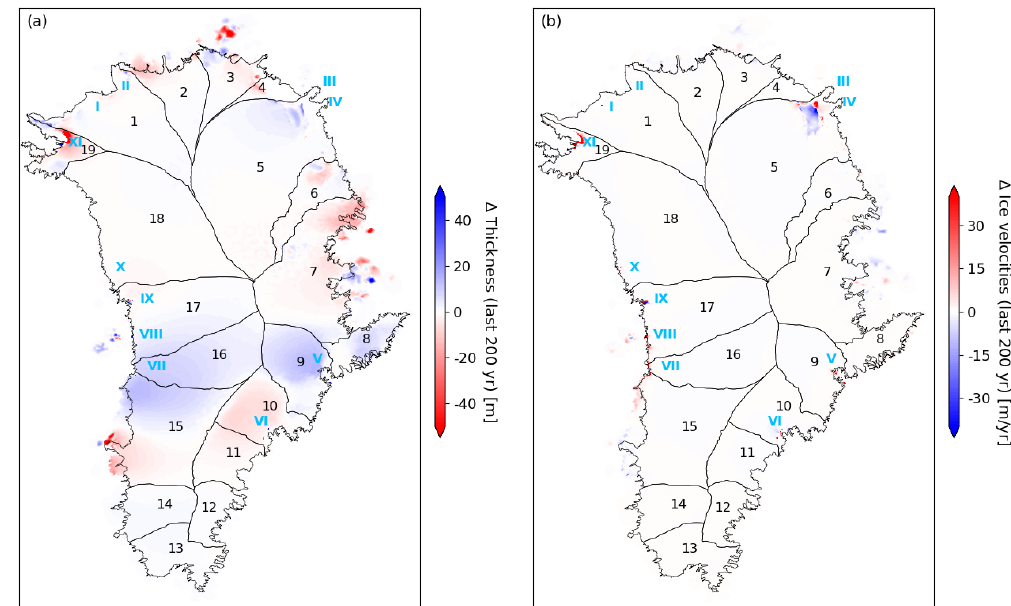
Figure A2. Differences in (a) ice thickness and (b) ice velocities over the last 200 years of the spin-up to a GrIS steady state. Arabic numerals (black) show the individual basins. Roman numerals (cyan) show the outlet glaciers where ice front movement is simulated and ocean melt parameterized.